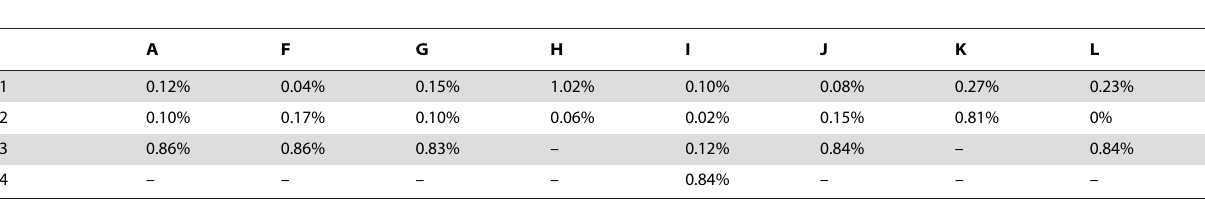
Table 3. PCR positive rates of Brucella among interclass levels of risk factors for Brucella contamination of raw